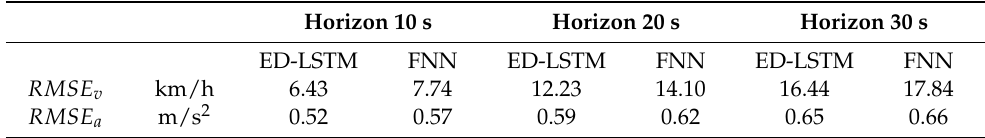
Table 2. RMSE without map data for different prediction horizons.